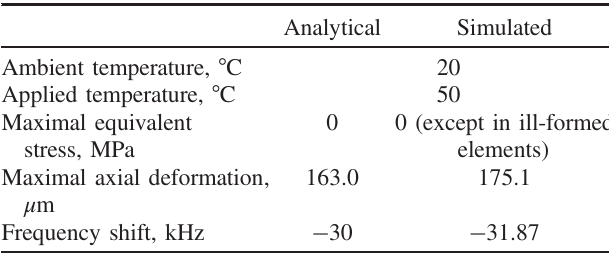
TABLE III. Comparison of the thermal and structural analysis results between ANSYS and CST.